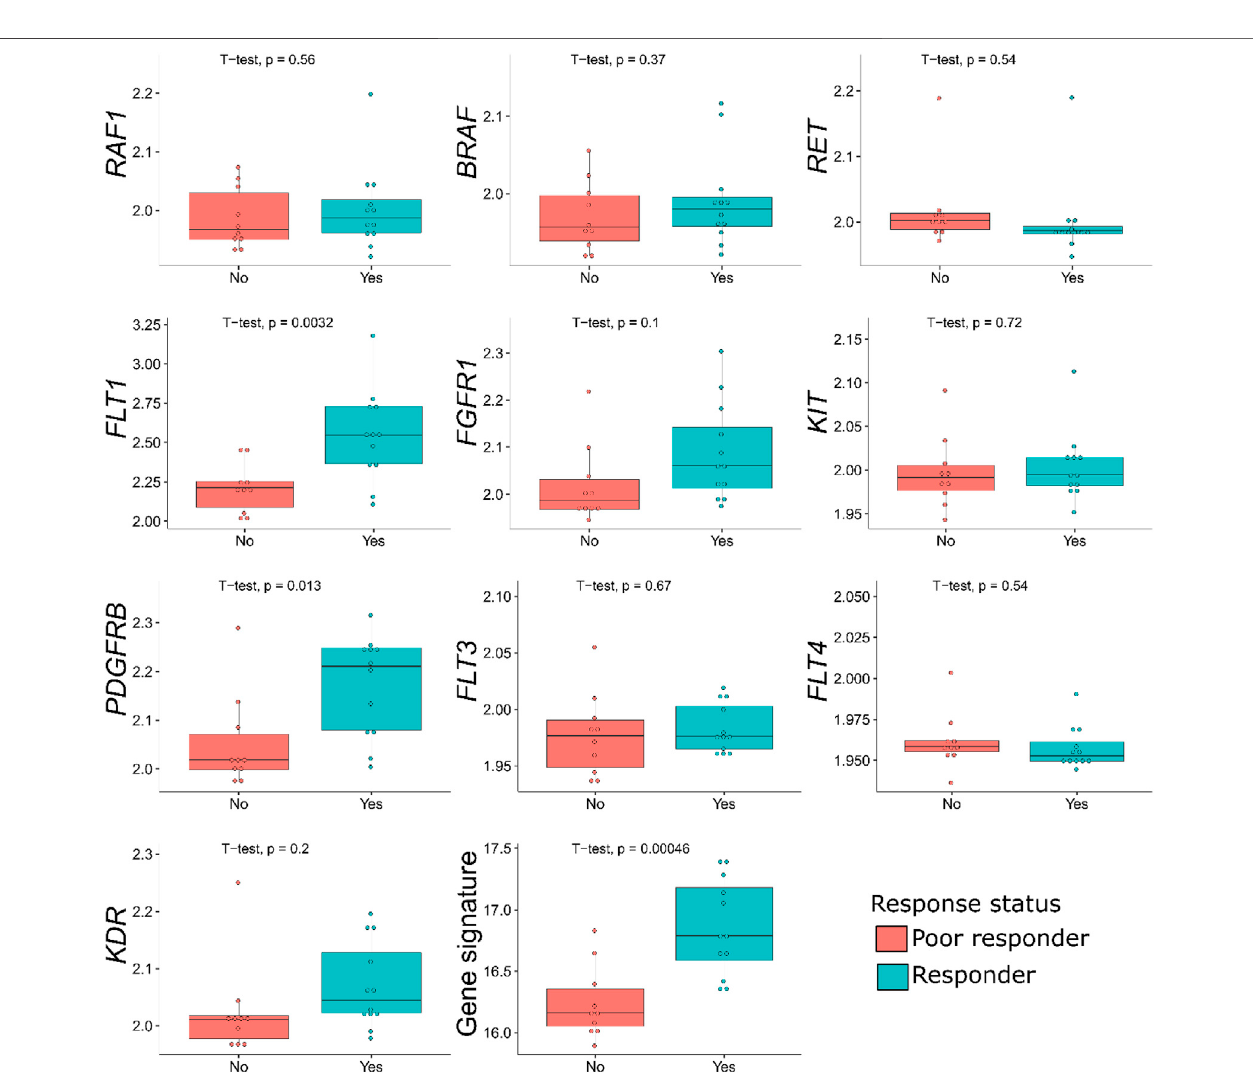
FIGURE1| Distribution ofsorafenib target geneexpressions, and ofthe genesignaturegenerated,amongthe sorafenib responder and poorresponder groupsof 22 RCC samples pro fi led by microarrays. For every gene, log10-transformed normalized expression is shown.